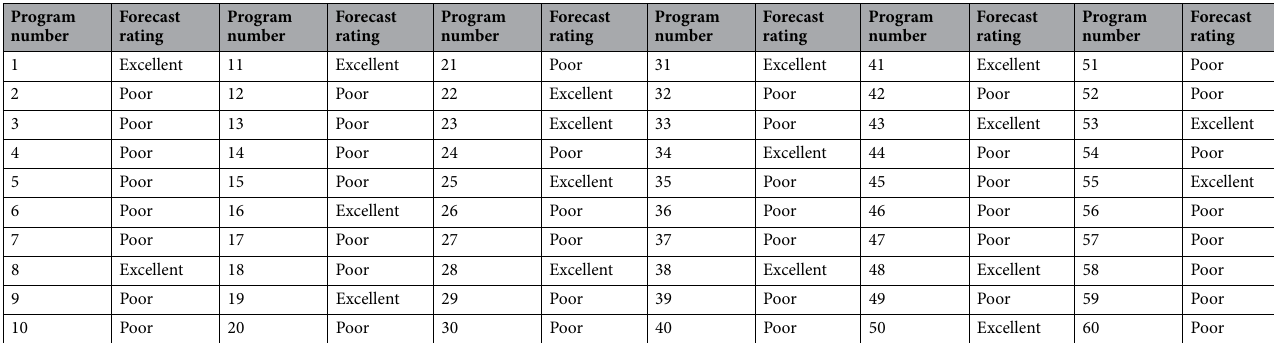
Table 6. Rating of MLP color